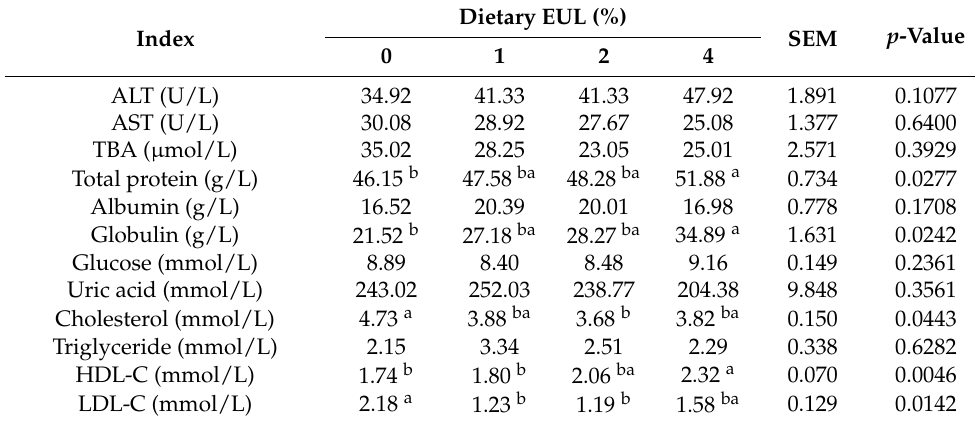
Table 3. Effects of dietary EUL on plasma parameters of laying ducks after 6 wk of feeding 1